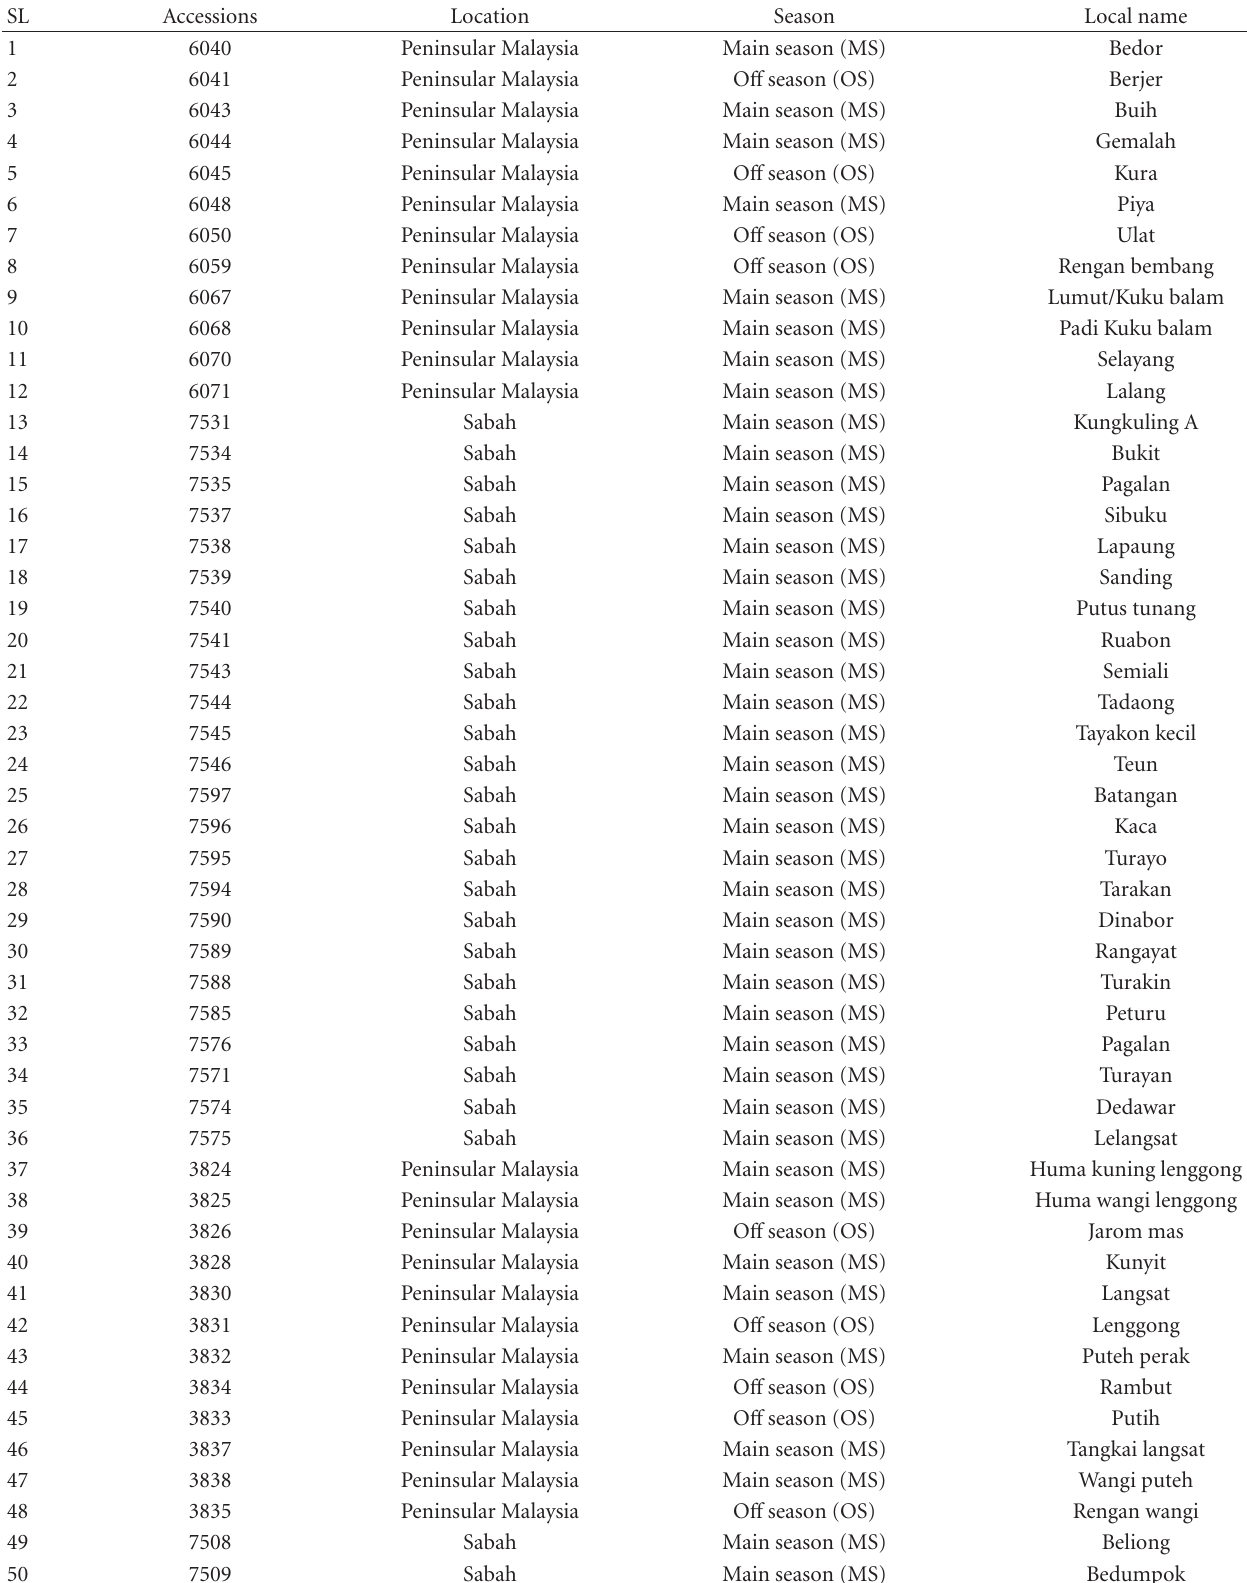
Table 1: Information on locations, seasons of seed collection and local name of the upland rice accessions.